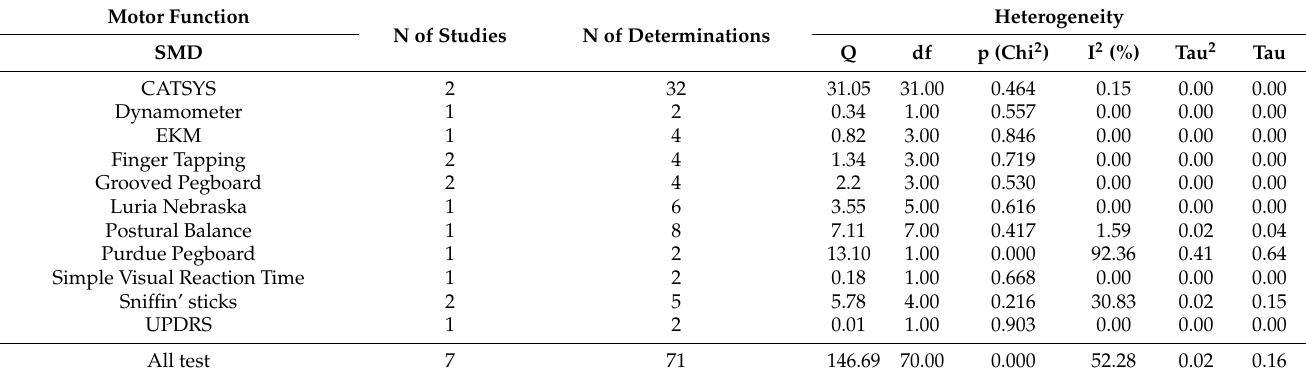
Table 6. Standardized mean differences (SMDs). Overall heterogeneity and as a function of the motor test used. Motor Function N of Studies N of Determinations